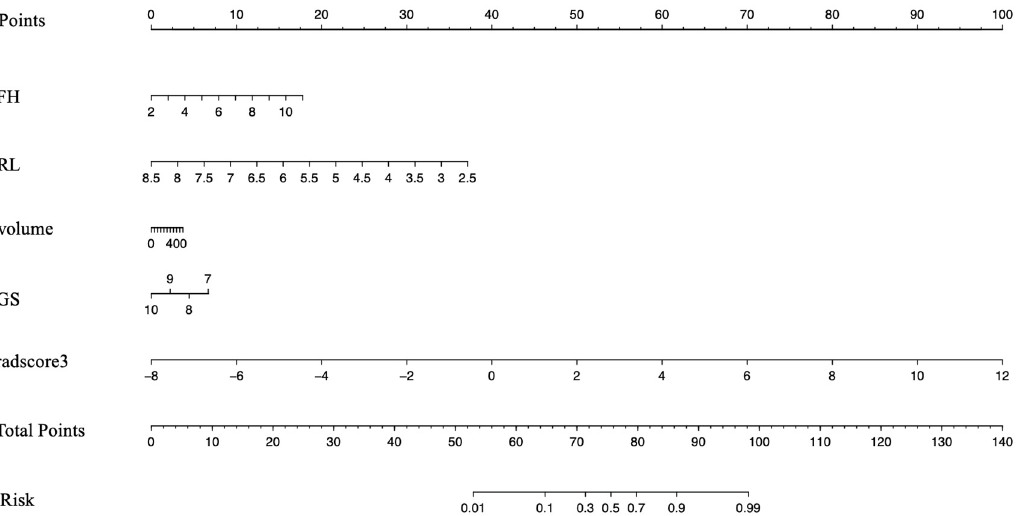
Figure 4. Nomogram developed for prediction of PNI. Radiomic nomogram combining the Rad- score derived from T2WI and DWI scans and clinical–radiological factors for predicting PNI. PNI: perineural invasion.